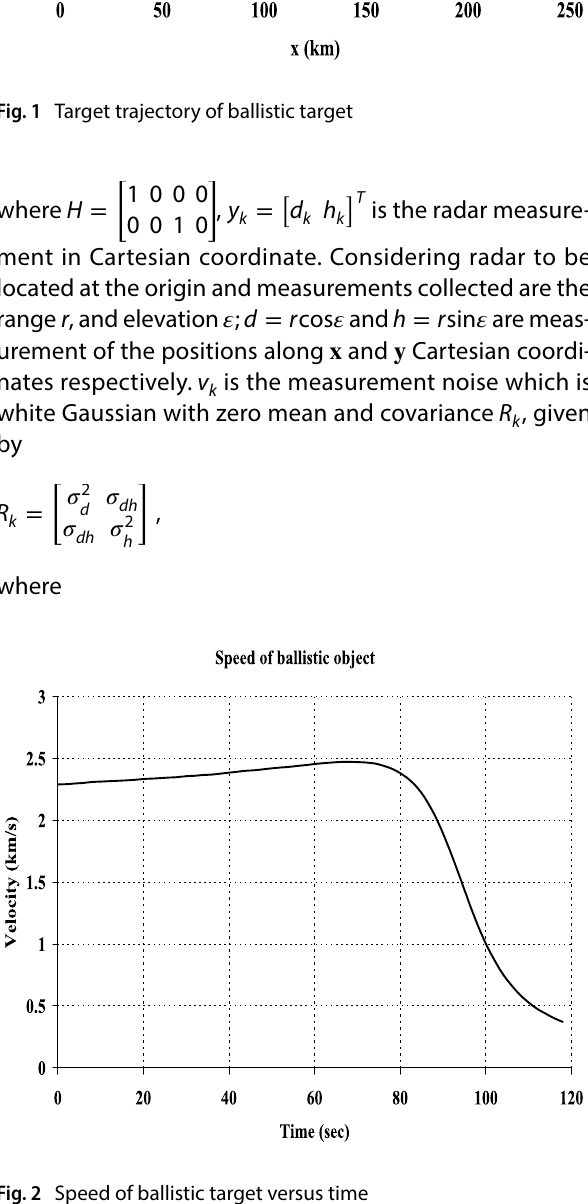
Fig. 2 Speed of ballistic target versus